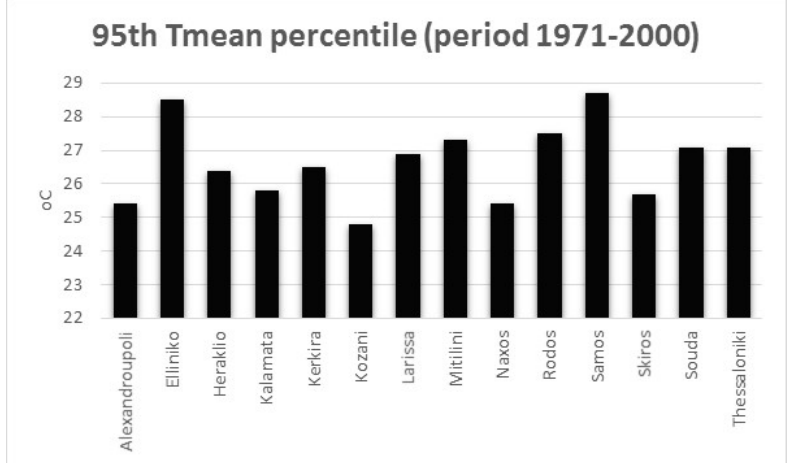
Figure 2. The 95th Tmean percentiles for the stations under study for the period 1971-2000.